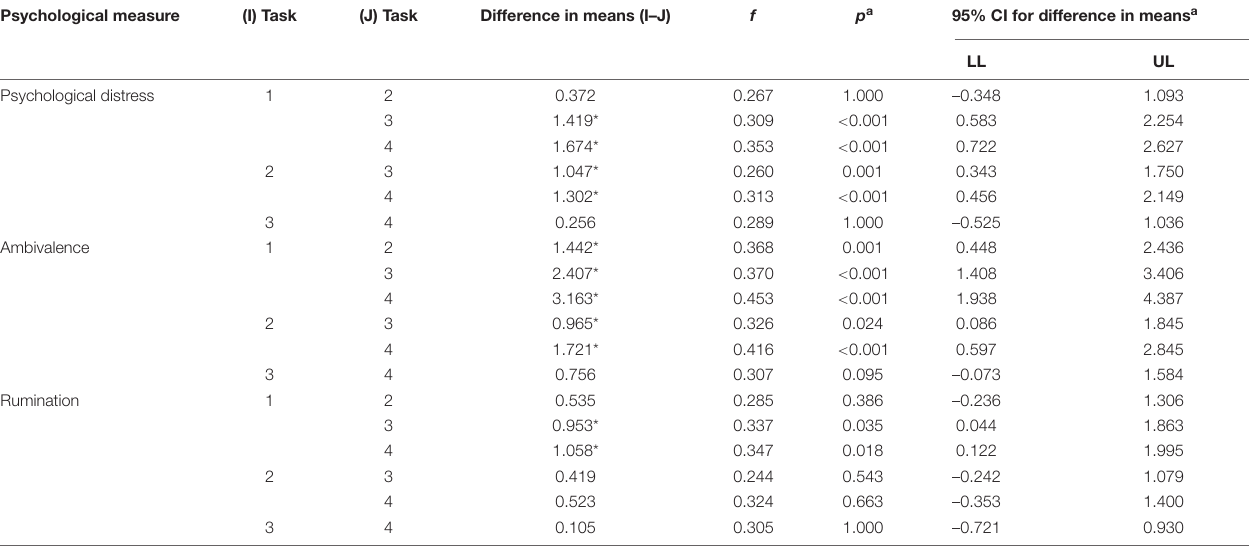
TABLE 7 | Pairwise comparisons for measures collected after the writing tasks. Psychological measure